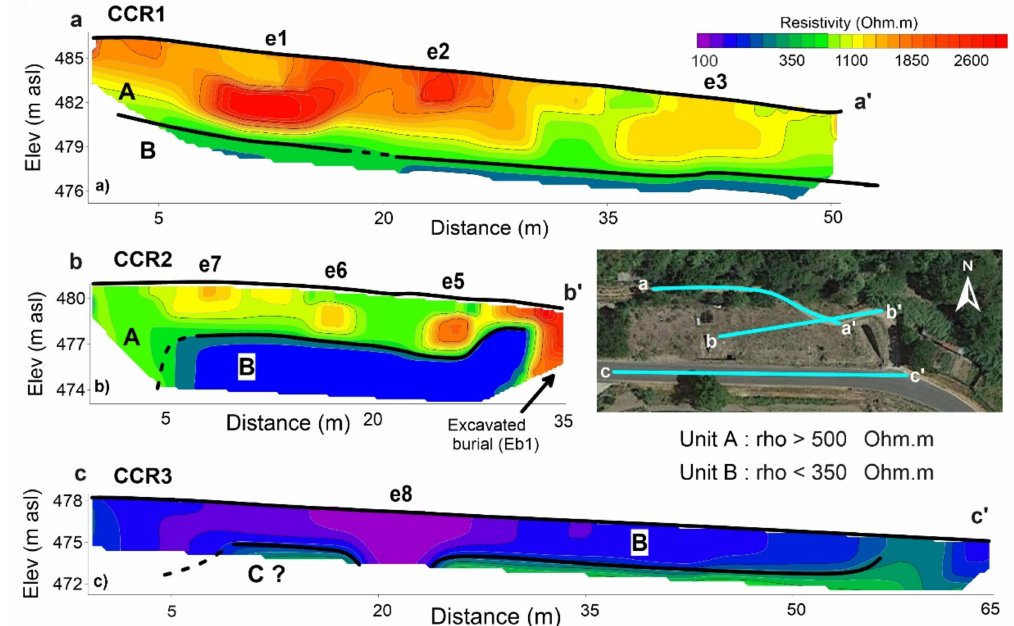
Figure 4. CCR resistivity sections. CCR inversion results of ( a ) profile a-a’, RMS 5.9% after six iterations (CCR1 in Figure 3); ( b ) profile b-b’, root mean square (rms) 5.4% after five iterations (CCR2 in Figure 3), and ( c ) profile c-c’, RMS 3.8% after five iterations (CCR3 in Figure 3). The solid black lines indicate the interpreted interface between units A and B. The topographies of the profiles were extracted via a high-resolution digital surface model (DSM). Recovered CCR anomalies are labeled with letters from e1 to